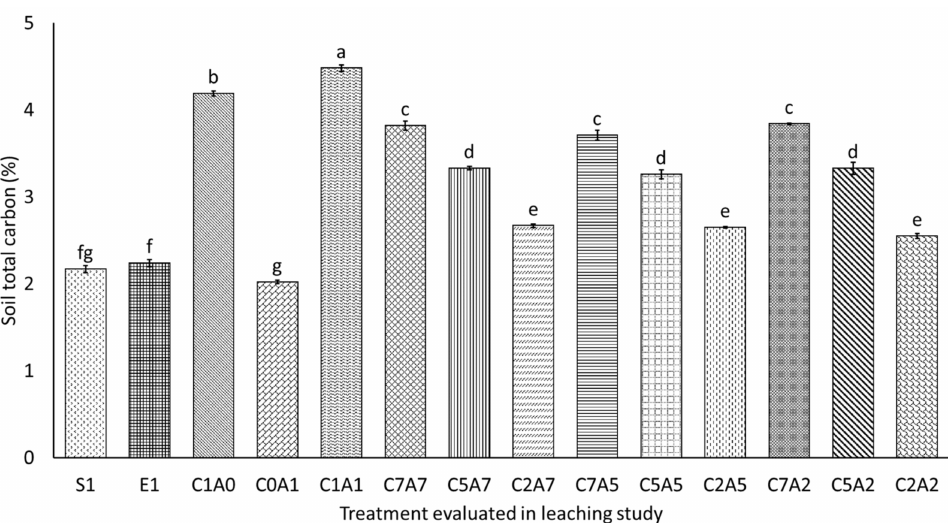
Figure 11. Treatments on soil total carbon after thirty days of leaching, where S1: soil only; E1: soil with ERP only; C1: 100% charcoal; C0: 0% charcoal; C7: 75% charcoal; C5: 50% charcoal; C2: 25% charcoal; A1: 100% sago bark ash; A0: 0% sago bark ash; A7: 75% sago bark ash; A5: 50% sago bark ash; A2: 25% sago bark ash. Means with different letter(s) indicate significant differences between treatments according to Tukey’s HSD test at p ≤ 0.05, that is, a > b > c. Bars represent the mean values ±